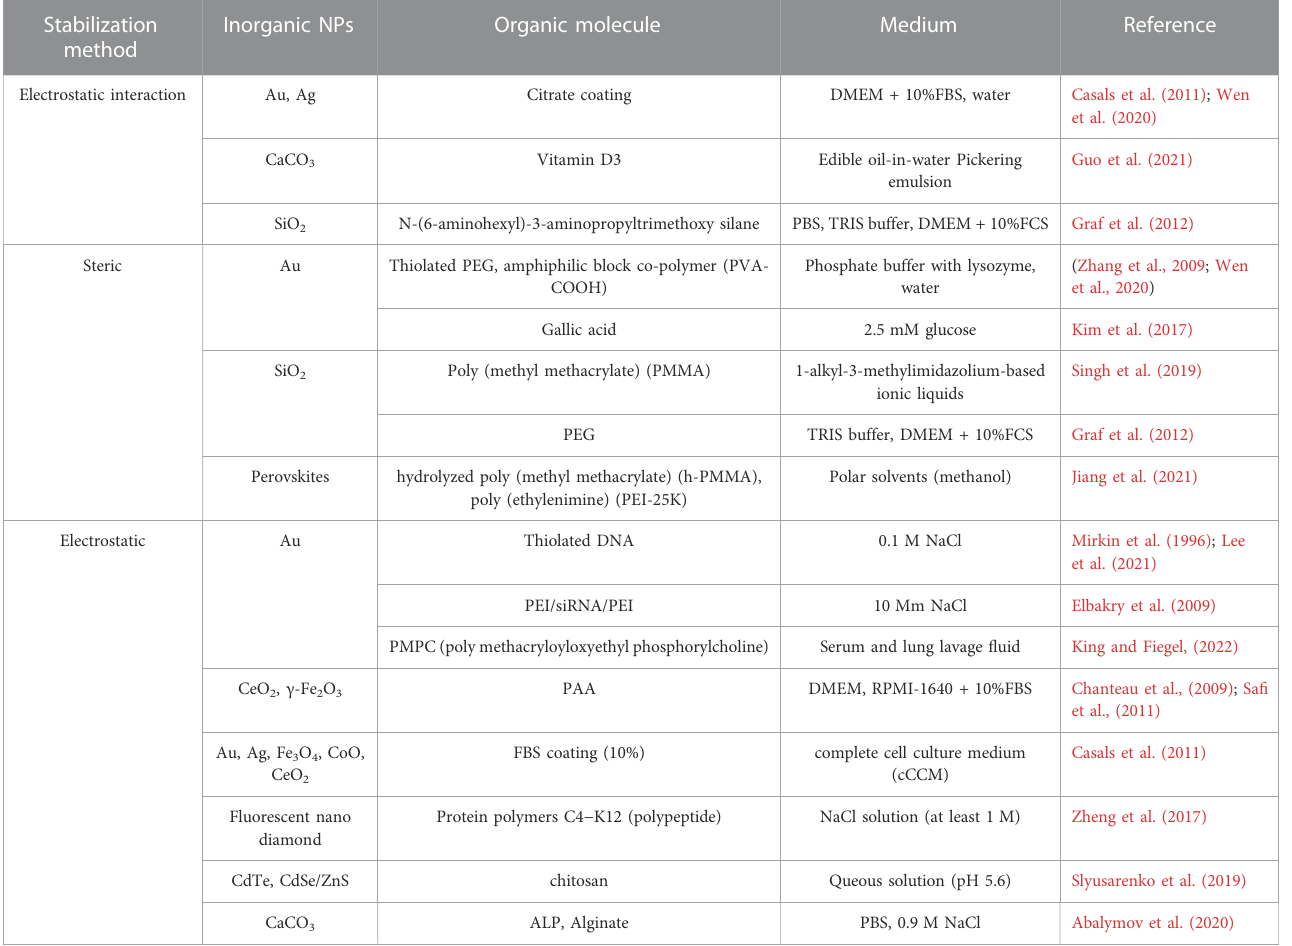
TABLE 2 The methods used to stabilize inorganic colloids via organic